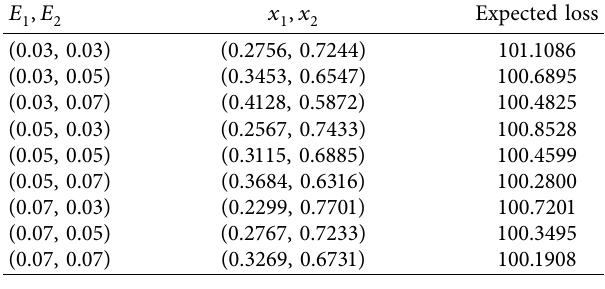
and E on the expected loss. 1 2